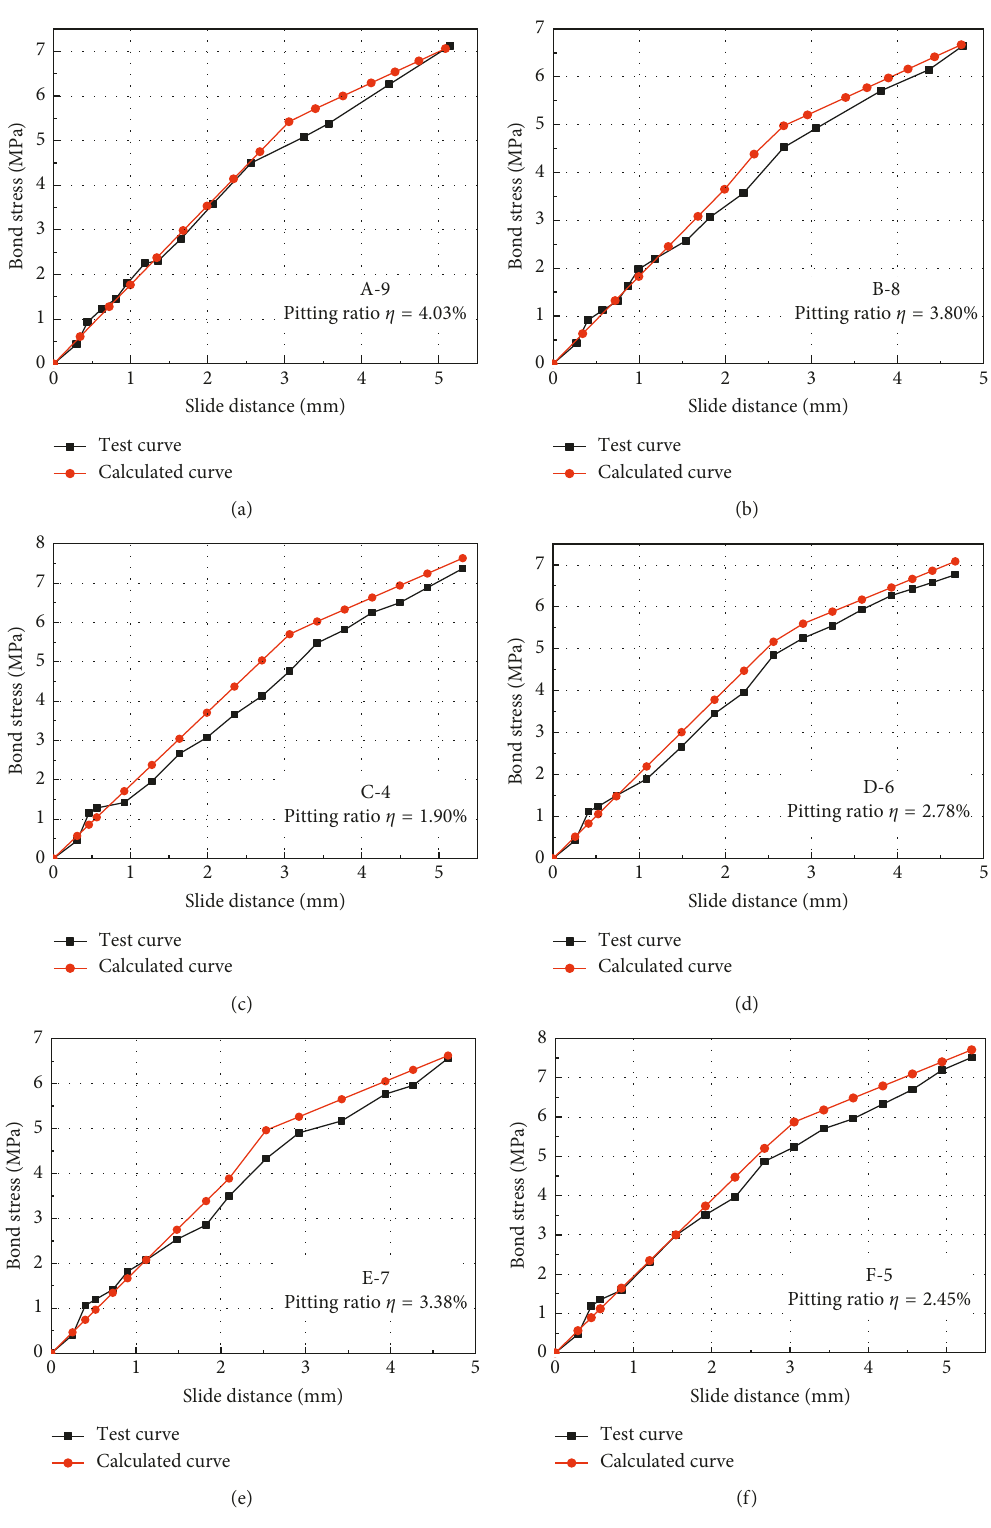
Figure 15: Comparisons between calculated results and test results of the bond-slide